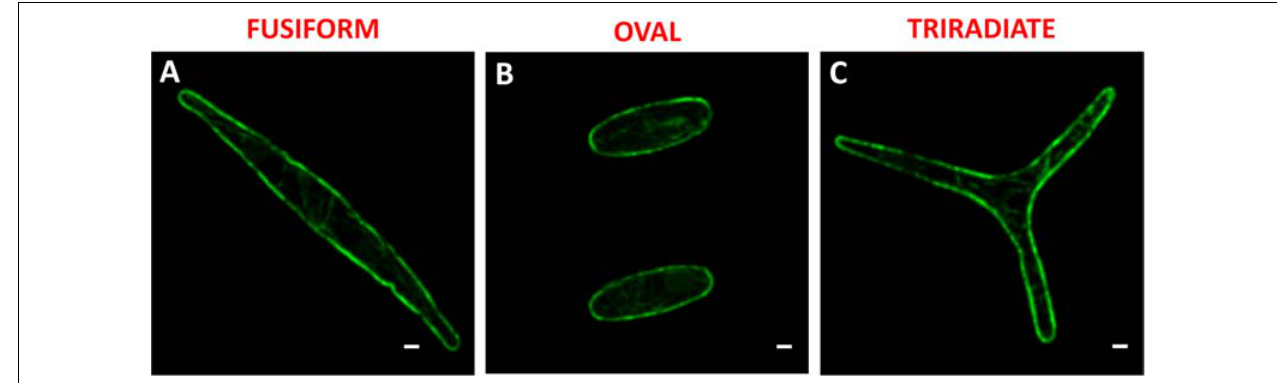
FIGURE 6 | Localization of actin in fixed P. tricornutum Pt3 morphotypes. (A–C) Localization of F-actin in Pt3 morphotypes after staining with Alexa 488-coupled phalloidin. Bars, 1 µ